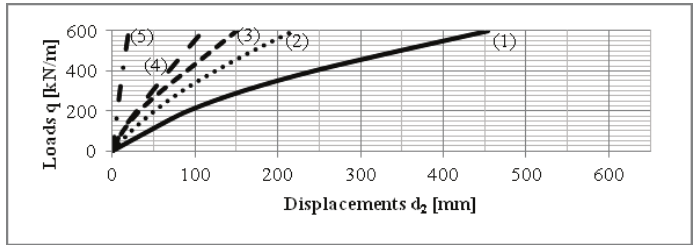
Fig. 4b. Displacements d 0 (mm) depending on the use of sheet piles as a cover of the foundation. Vertical load applied at the bearing points